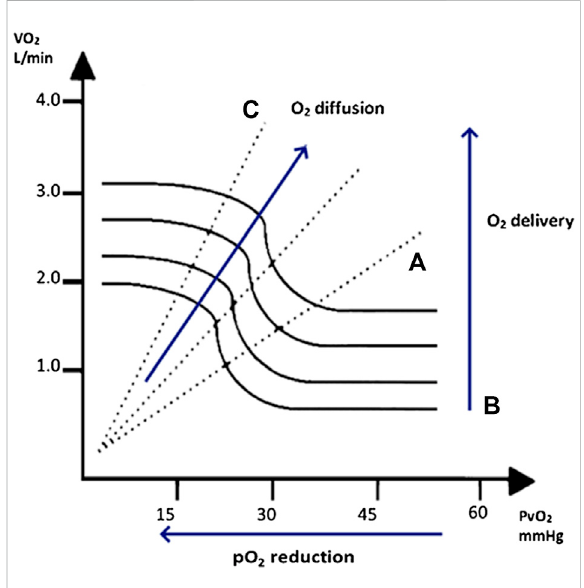
FIGURE 1 On the left, the relation between the O 2 venous pressure (PvO 2 ) and oxygen uptake (VO 2 ) represented by Wagner diagram with the trend of O 2 diffusion, O 2 delivery, and O 2 pression (pO 2 ) reduction. During exercise VO 2 increases by three independent mechanisms: (A) increase in O 2 delivery (exercise- induced cardiac output increase and hemoconcentration (bold lines); (B) pO 2 reduction in the capillary bed ( X axis); and (C) differences in O 2 diffusion from the capillary to the mitochondria (dashed lines). Reproducedwith permission from Rovai et al., 2021 (Rovai et al.,